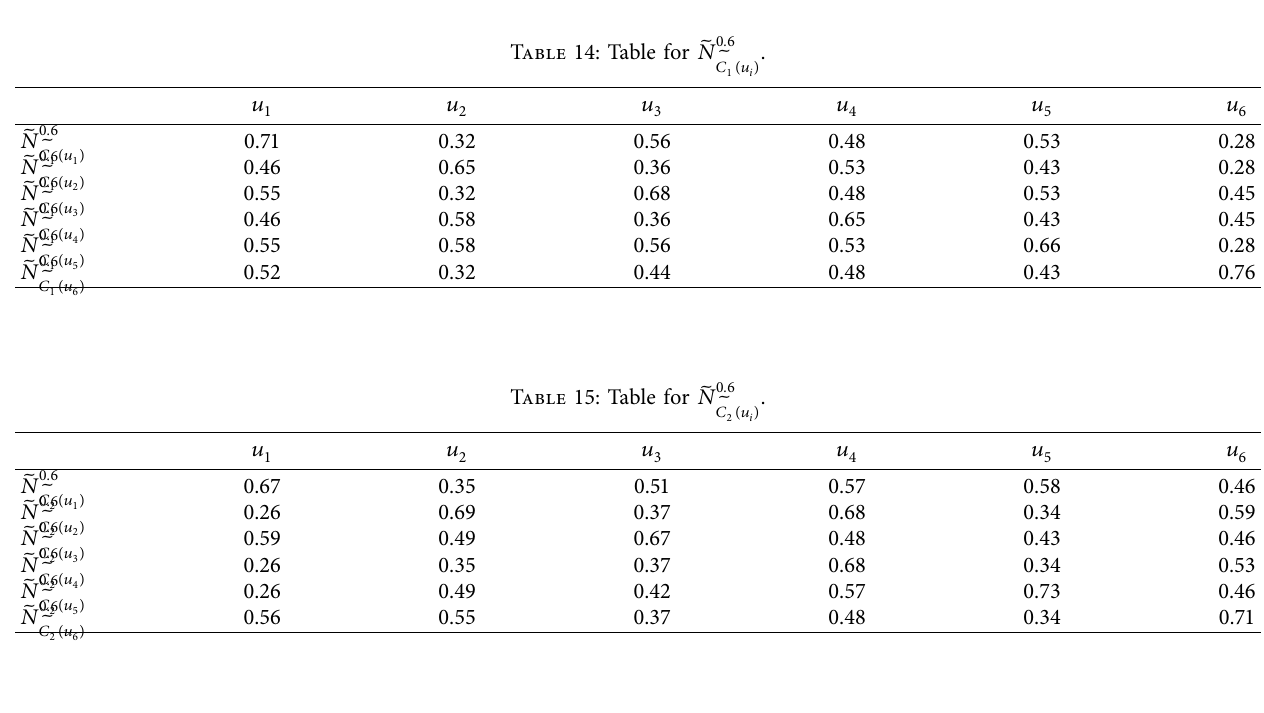
Table 16: Table for 􏽥 N 0 . 6 􏽥